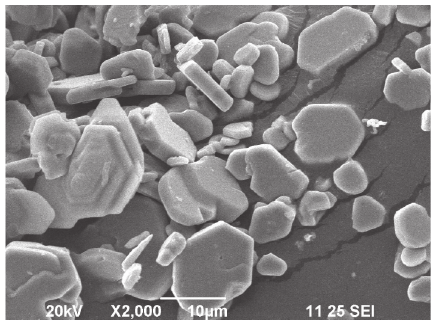
Figure 7: SEM image of TiB